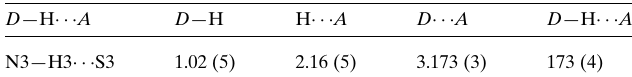
Table 2 Hydrogen-bond geometry (A˚ , (cid:4) ) for (II).